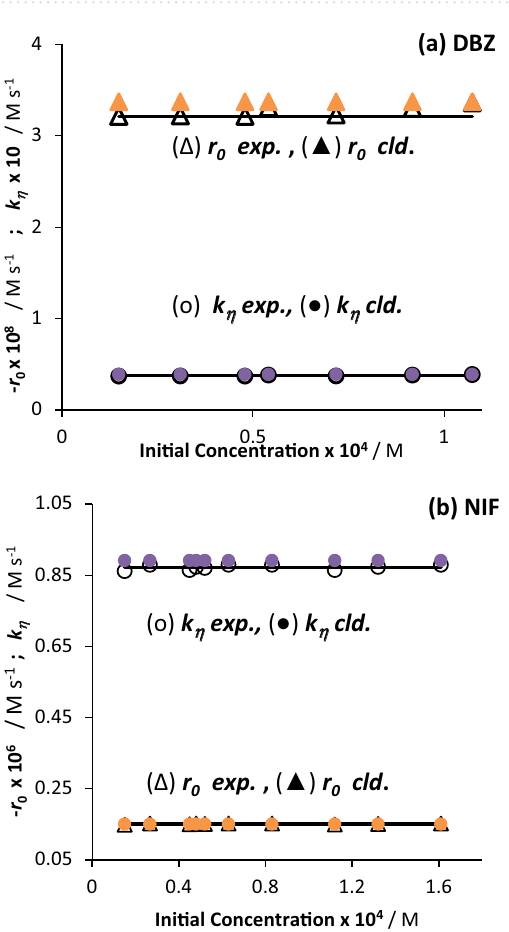
η 0, exp for ( a ) DBZ and ( b ) NIF with different initial concentrations